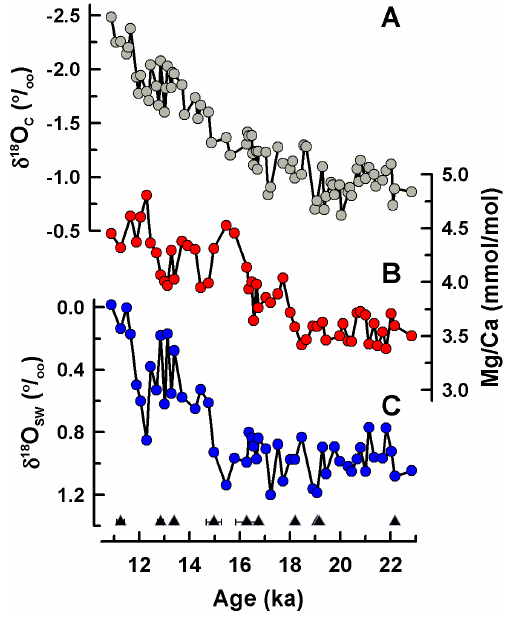
Figure 3. Planktonic foraminifera G. ruber geochemical proxy records of site MD05-2925, including (a) oxygen isotope ( δ 18 O C ), (b) Mg/Ca ratio, and (c) temperature corrected-only seawater oxy- gen isotope ( δ 18 O SW ). Triangle symbols are corrected radiocarbon dates (Table 1).